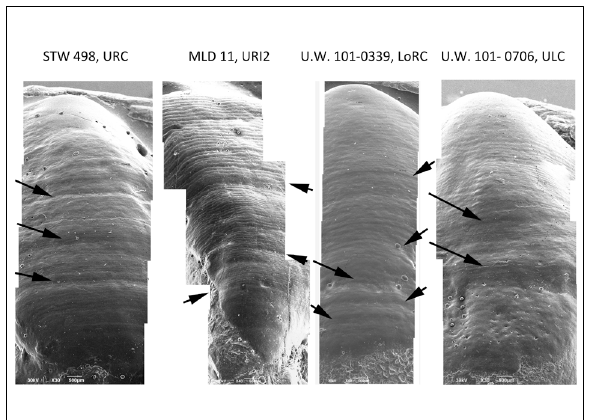
Figure 1: Examples of teeth with repetitive linear enamel hypoplasia (arrowed): STW=Sterkfontein ( Australopithecus africanus ), MLD = Makapansgat ( Australopithecus africanus ), U.W.101= Homo naledi ; U=upper, Lo=lower, L=left, R=right. Thresholds for diagnosis of any particular defect are based on agreement among scanning electron micrographs (shown here), and scanning and digital microscopy images.